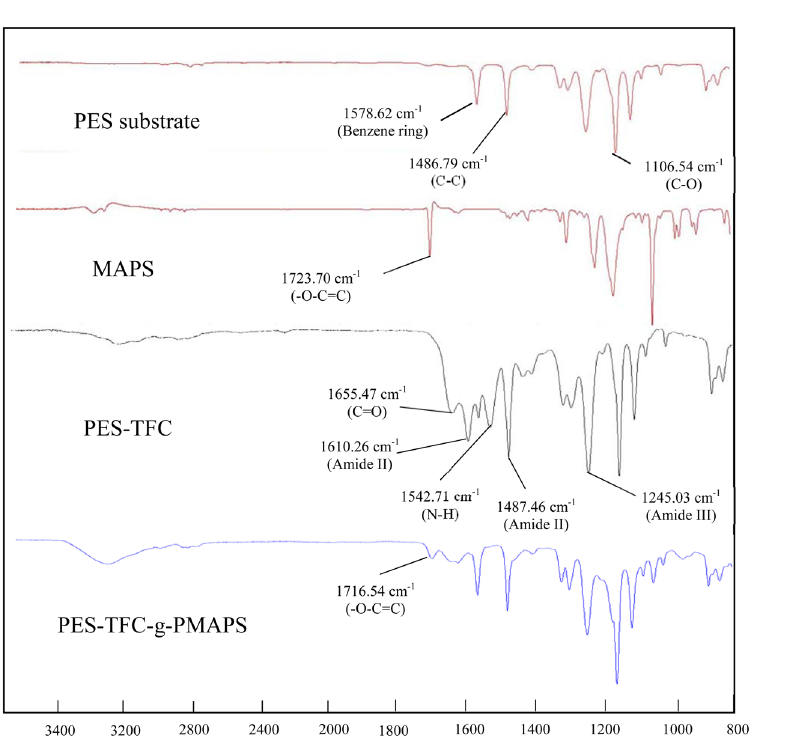
Figure 8. FTIR spectra of